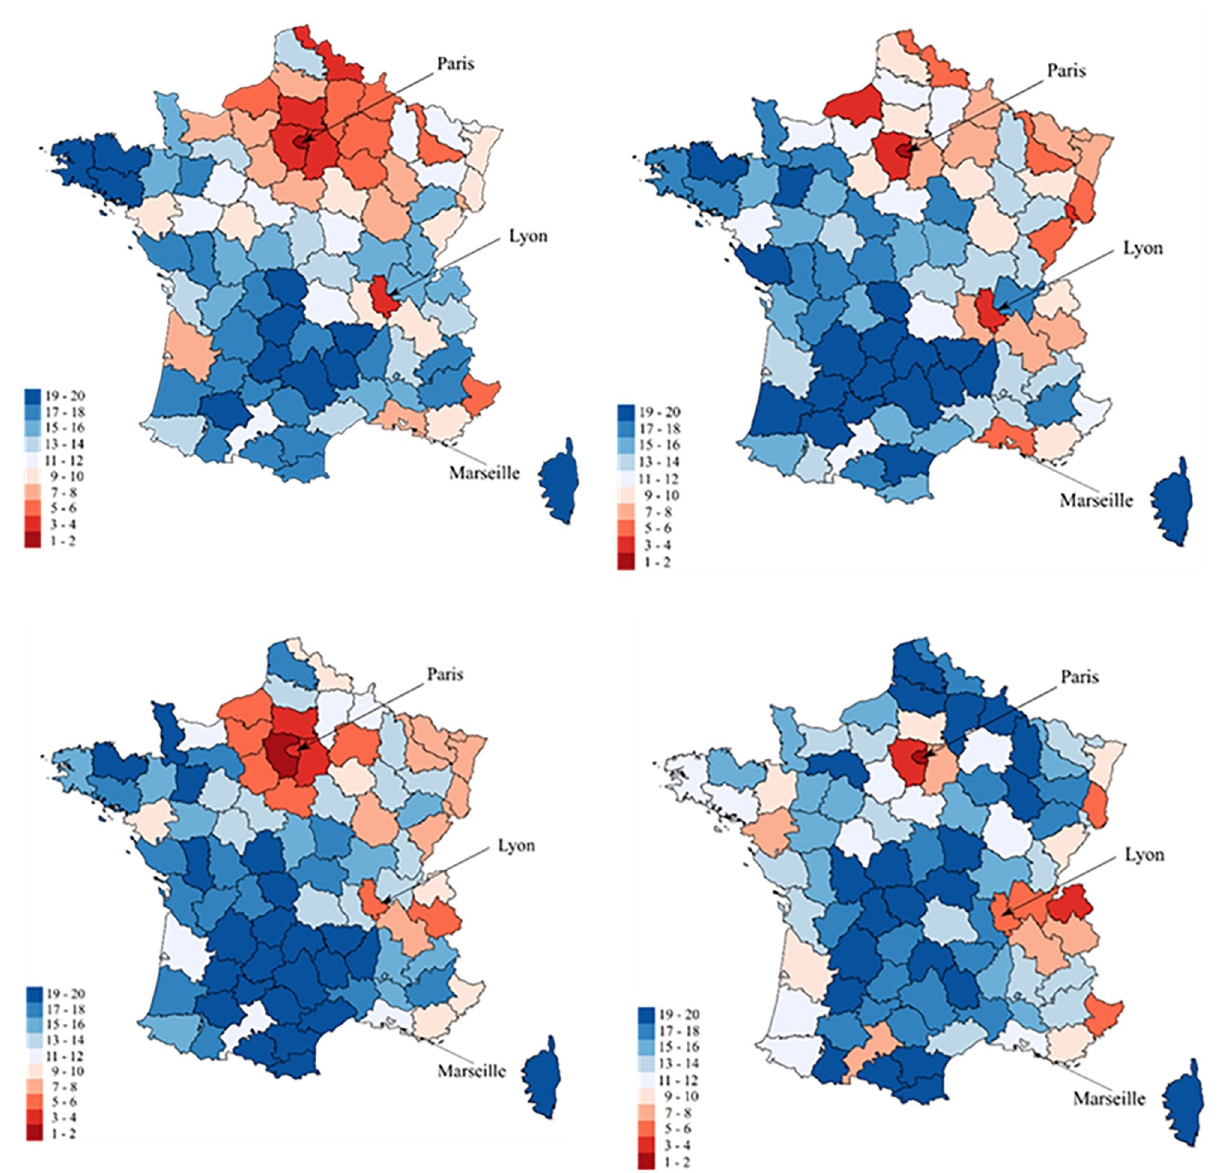
Fig 5. 20 ventiles of de´partements in 1925, 1950, 1975 and 2020. De´partements are classified according to their place in the 20 ventiles. The richest de´partements are in dark red while the poorest ones are in dark blue.